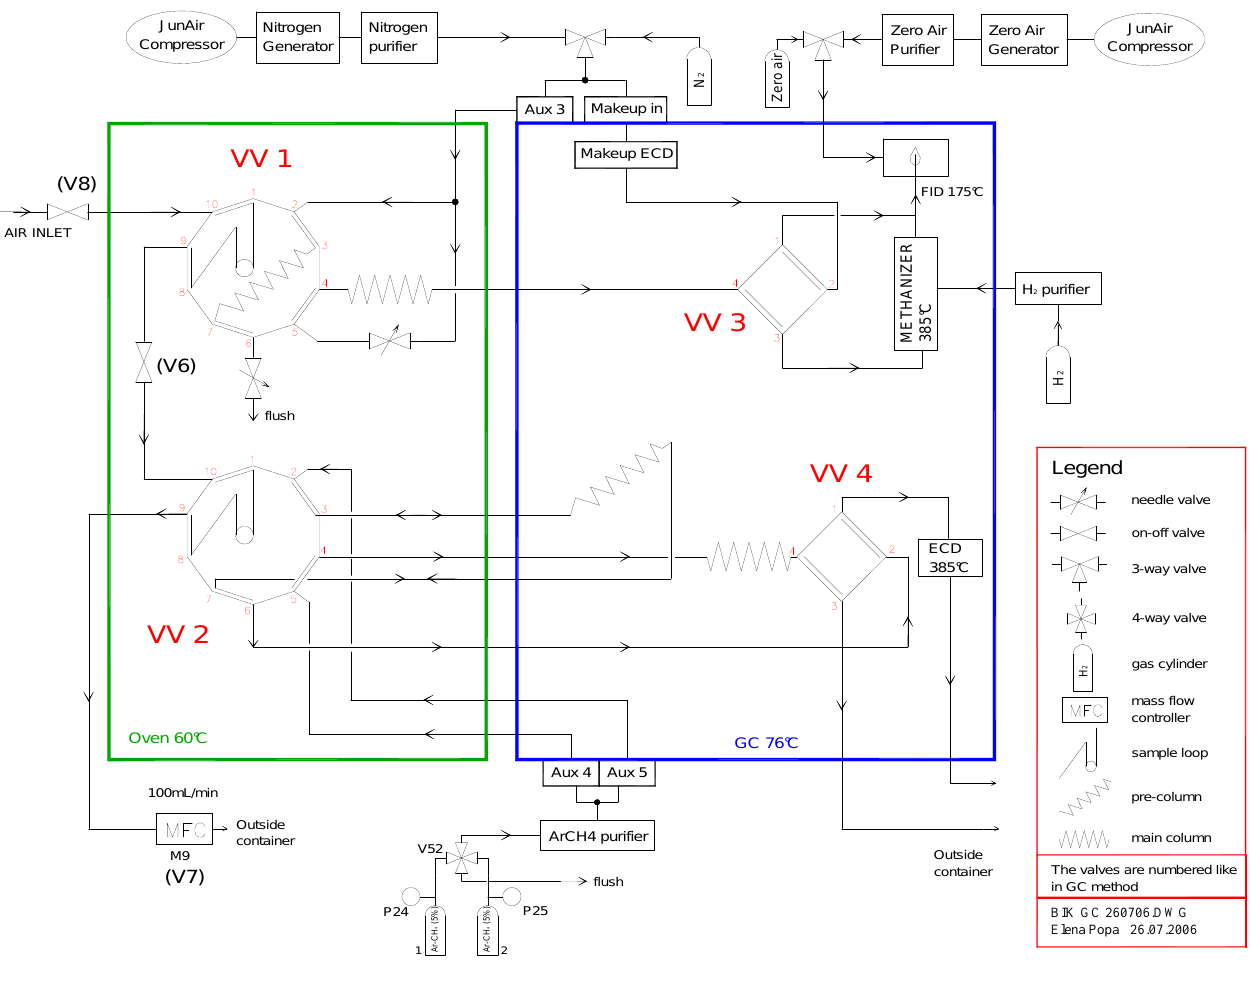
Fig. 3. The GC system diagram – LOAD position.